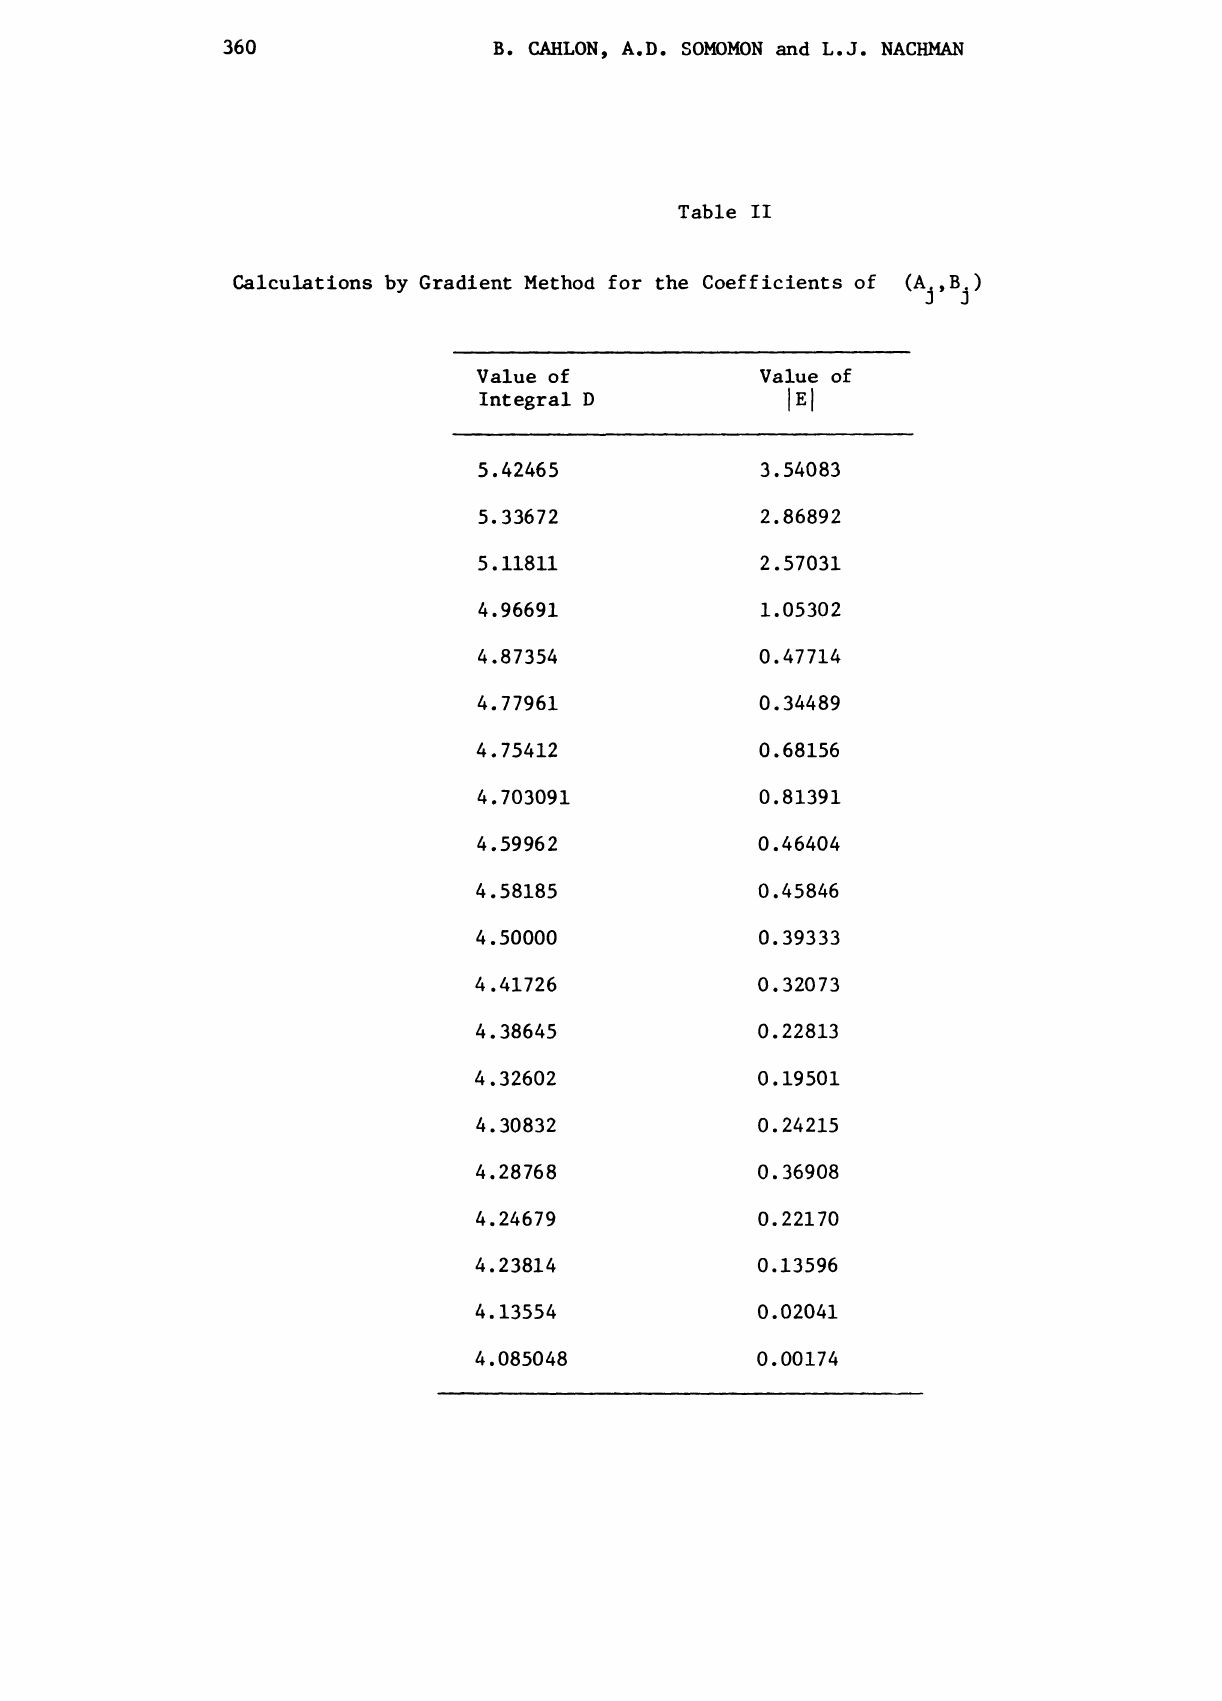
Calculations by Gradient Method for the Coefficients